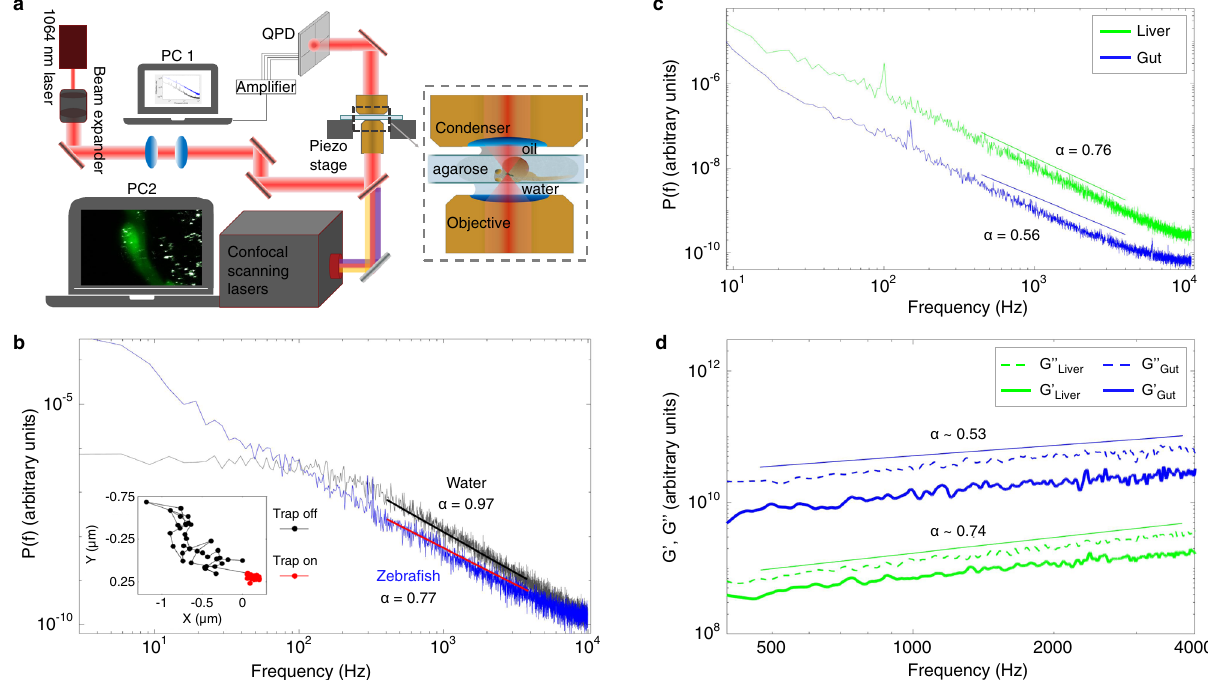
Fig. 2 Forward-scattered light from optically trapped nanoparticles in living zebra fi sh can be used to infer cellular viscoelasticity. a Schematic of the setup for laser tracking of nanoparticles in vivo: the laser beam (1064 nm, red line) is focused in the embryo (inset) and the forward-scattered light is collected by a condenser and imaged onto a quadrant photodiode (QPD). In all optical trapping experiments, the immobilized zebra fi sh were mounted dorsolaterally in agarose on a microscope slide with the liver bud facing the objective. b Examples of positional power spectra of optically trapped particles in water (black, α = 0.97) or in a zebra fi sh embryo (blue, α = 0.77). The straight lines show fi ts of Eq. (1) to data. The inset shows the trajectories of a trapped (red) and a freely diffusing (black) particle in the foregut region of a living zebra fi sh embryo. c Power spectra of optically trapped nanoparticles in liver (green) or gut progenitors (blue). Full lines show linear fi ts to the double logarithmic plot in the frequency interval 400 Hz < f < 4000 Hz, yielding scaling exponents of 0.56 ± 0.08 (gut) and 0.76± 0.06 (liver), respectively. d Symbols (blue and green) provide the storage moduli, G ’ , of the gut and liver, same colors as in ( c ) and ( d ). The corresponding loss moduli, G ” , are shown with dashed lines for comparison of the amplitude. G ” dominates G ’ over the 400 – 4000 Hz frequency interval for both tissue types. The full lines show fi ts to the loss moduli data in the corresponding region to the power spectra ( c ), returning scaling exponents of 0.53 ± 04 (gut) and 0.74± 0.05 (liver). The data shown in ( c , d ) is an average of fi ve experiments for each cell